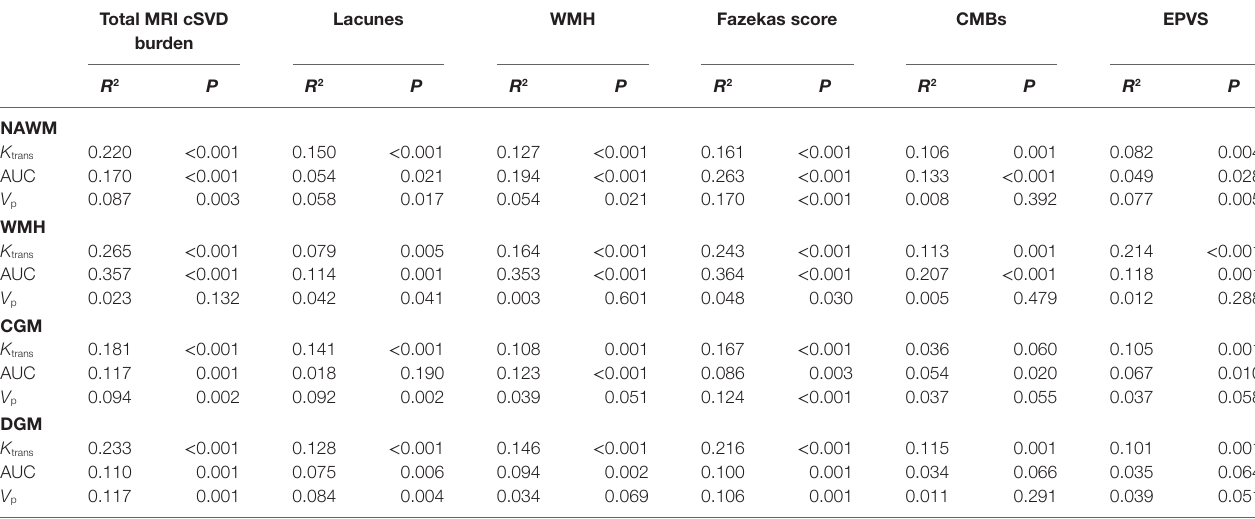
TaBle 4 | R 2 for the association between BBB permeability and total MRI cSVD burden versus individual MRI markers. Total Mri csVD lacunes WMh Fazekas score burden